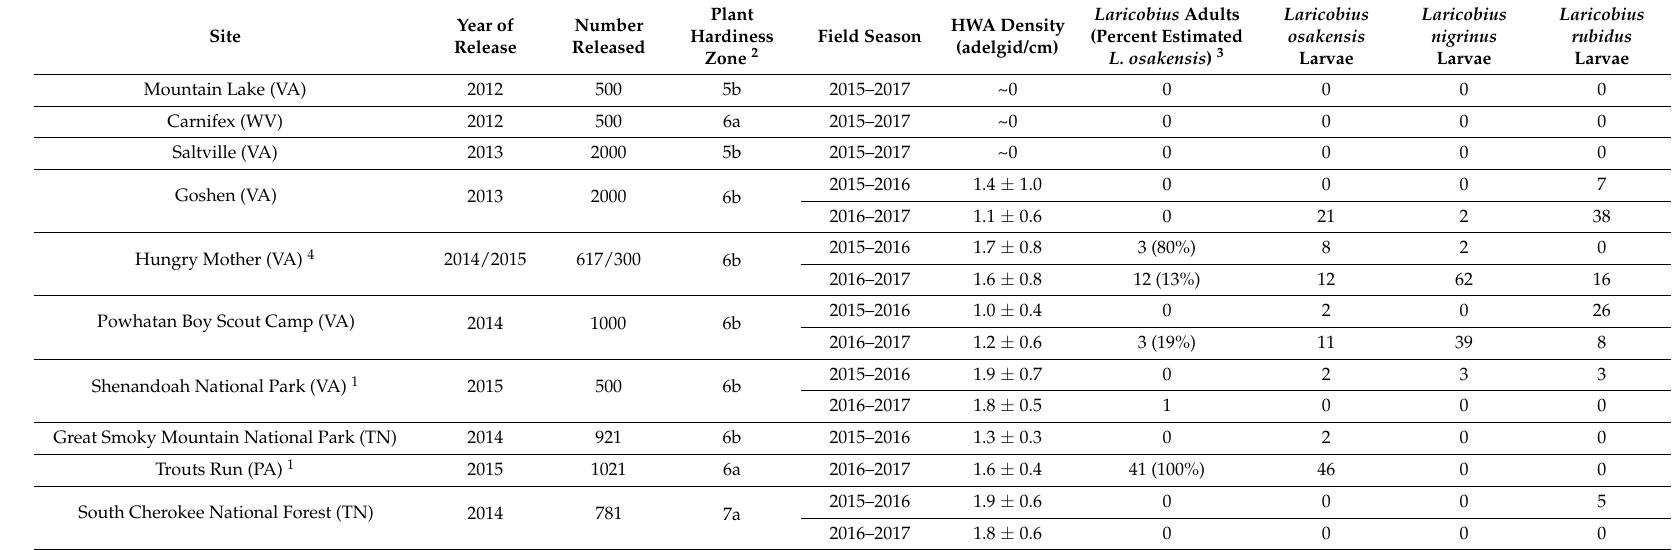
Table 2. Field collections of Laricobius spp., including information on site location, plant hardiness zone of the field site, year of beetle release, number of beetles released, and Adelges tsugae (HWA) density (adelgids/cm) at time of